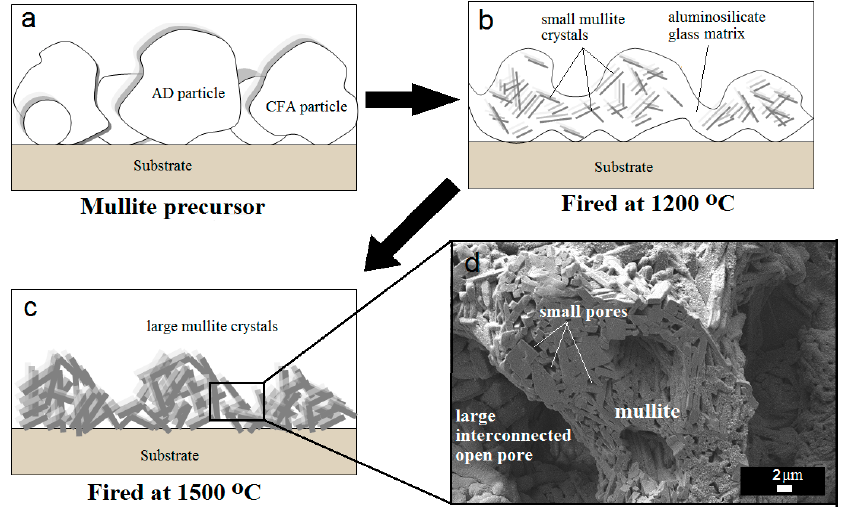
Figure 6. Cross-sectional schematic diagrams showing the mullite washcoat formation mechanism, ( a ) agglomerated AD and CFA particles as mullite precursor; ( b ) melting and fusing of particles—small acicular mullite crystals embedded in aluminosilicate glass matrix; ( c ) dimensional shrinkage and formation of hierarchical porous structure with large interlocked acicular mullite crystals; ( d ) small pores and large interconnected open pores in the microstructure.